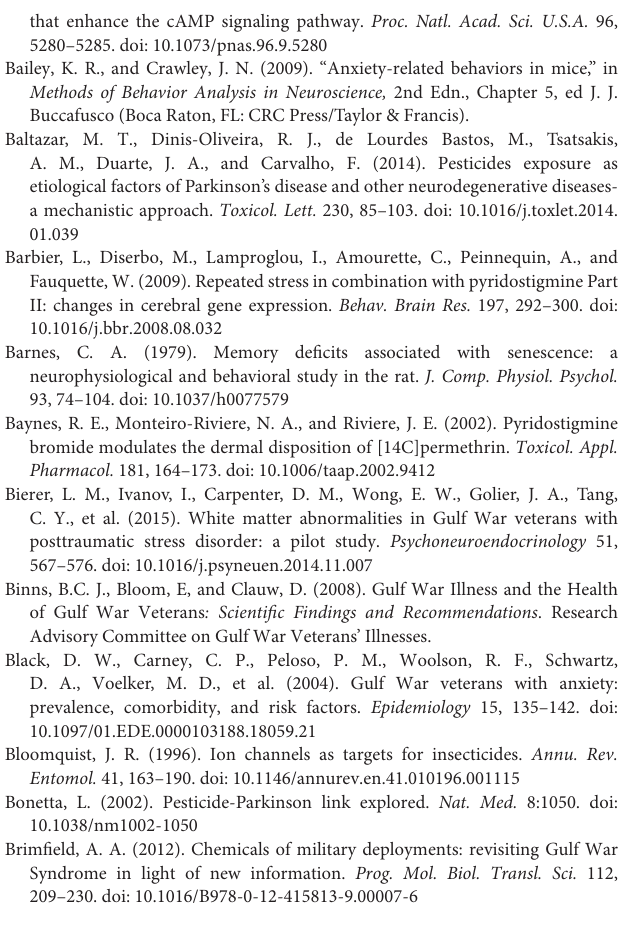
Supplementary Figure 1 | Schematic illustrating the battery of neurobehavioral testing undertaken from 11 days to 22.5 months (684 days) post exposure to GW agents, PB +